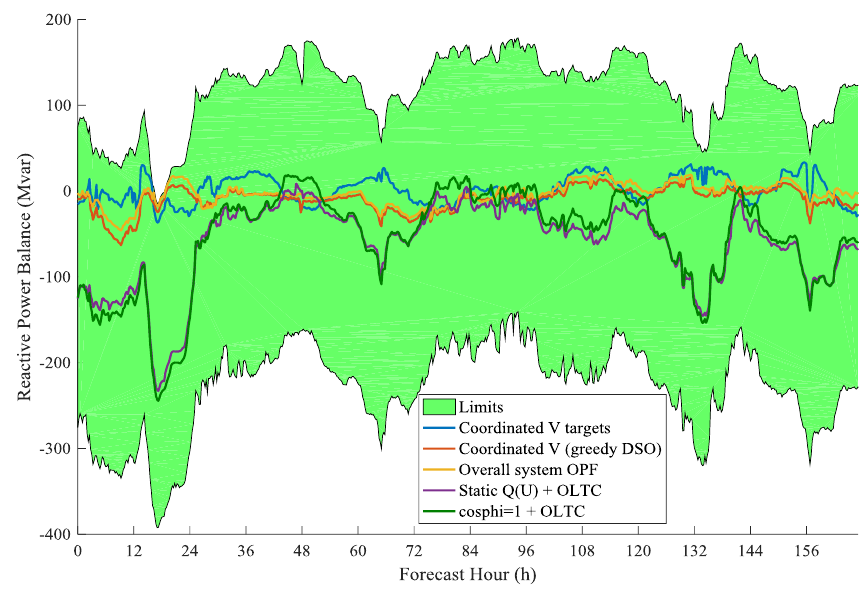
Figure 16. Reactive power exchange between transmission and distribution grid (weekly).